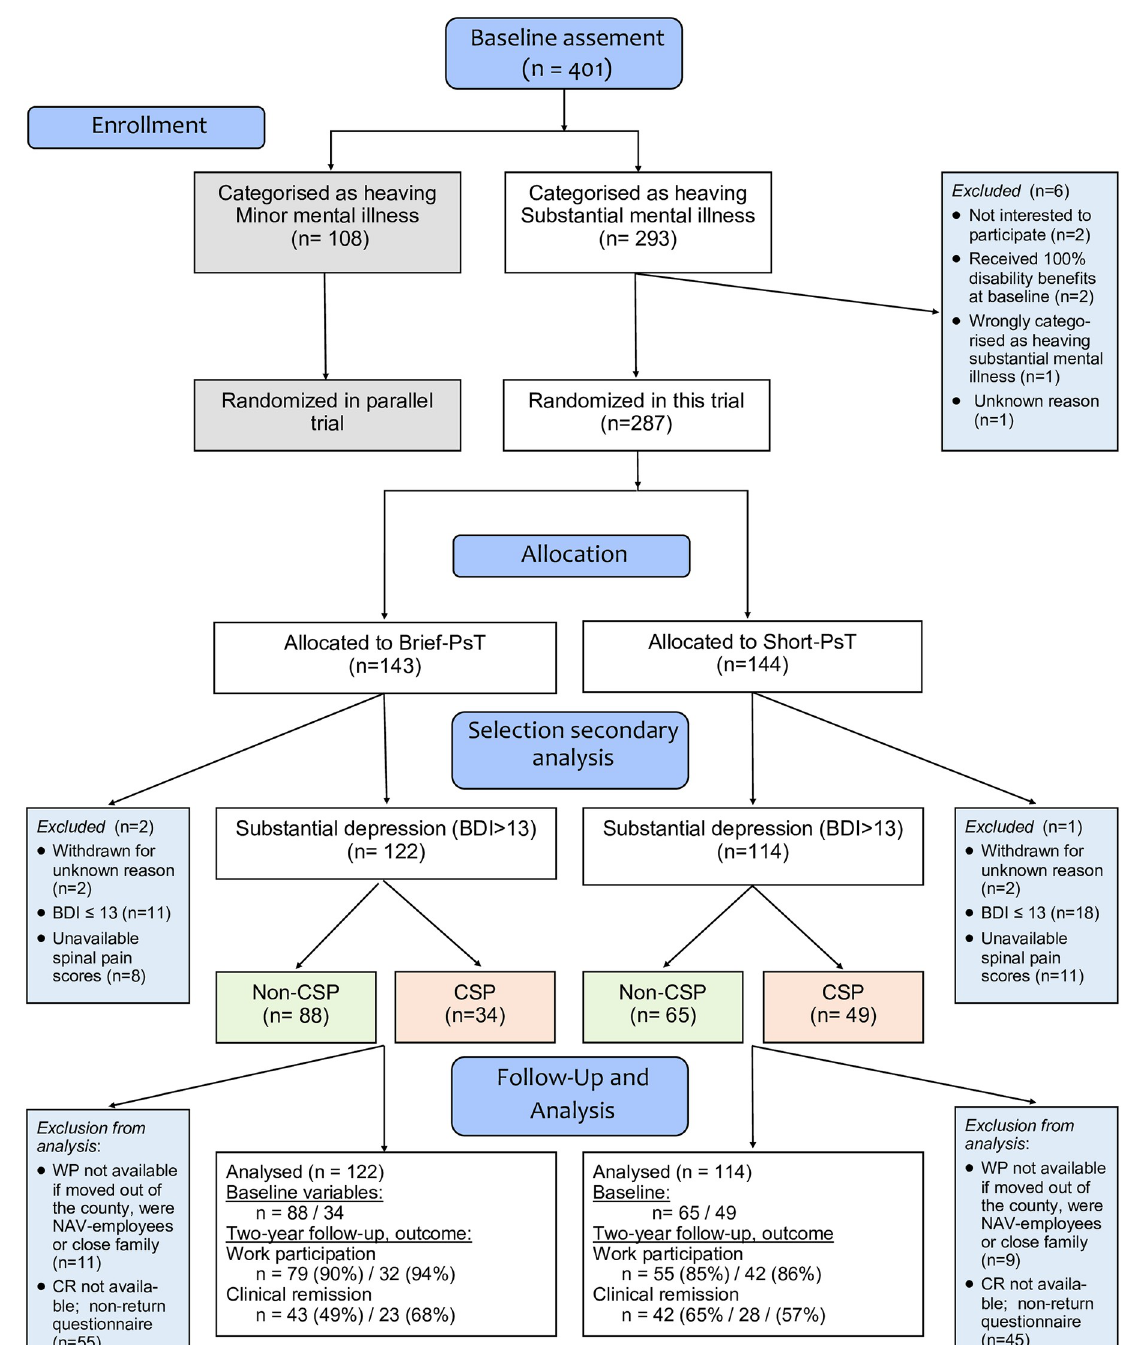
Fig 1. Flowchart. The initial screening procedure has been reported in a previous publication [27]; CSP-Comorbid Spinal Pain; BDI- Beck Depression Inventory-II.